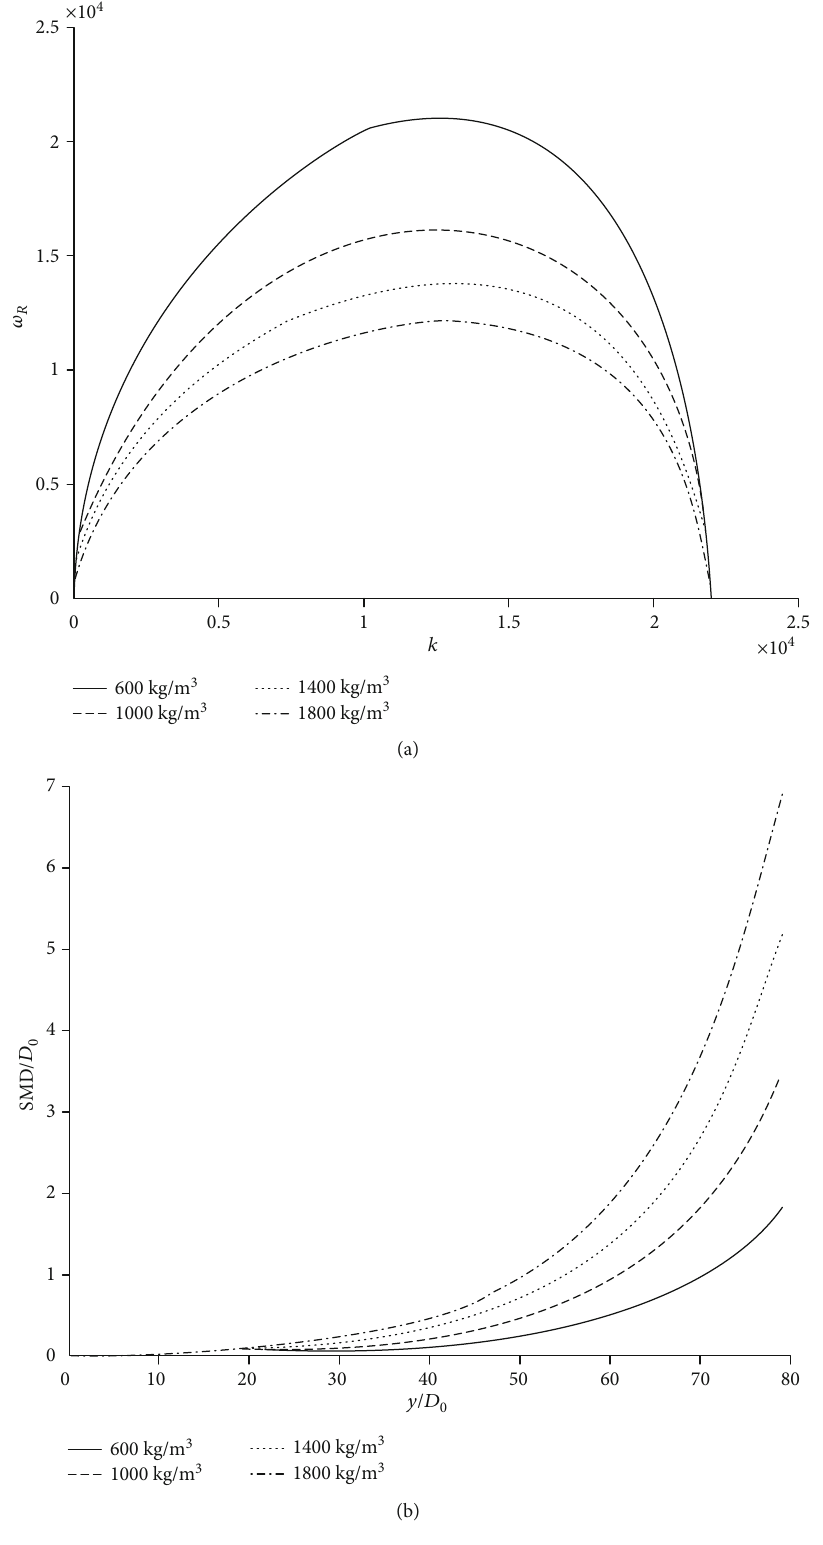
= 1 : 29 kg/m 3 , u = L G